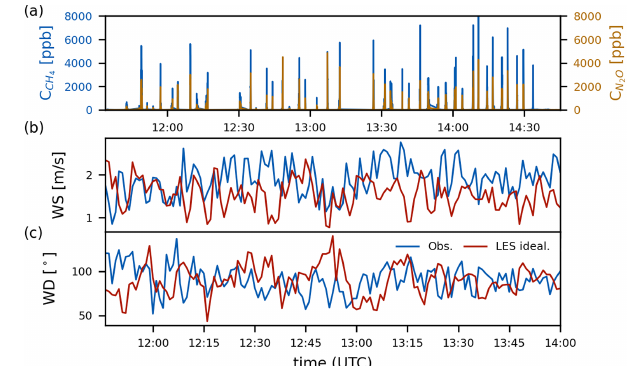
Figure 6. (a) CH 4 molar fractions measured over the road adjacent to the emitting oil well and N 2 O molar fractions from emissions next to the well. Comparison of the observed and simulated (b) hor- izontal wind speed and (c) horizontal wind direction. The values are given as 1min averages of instantaneous wind. The dotted lines are rolling means of respective wind speeds, shown here for easier interpretation of the mean wind